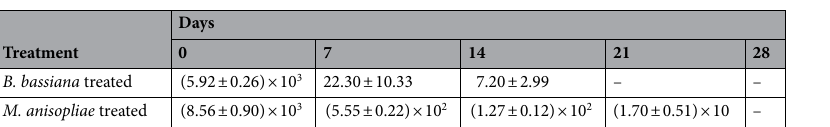
Table 2. Effects of B. bassiana and M. anisopliae on biomass of maize seedlings after 35 days of treatment.